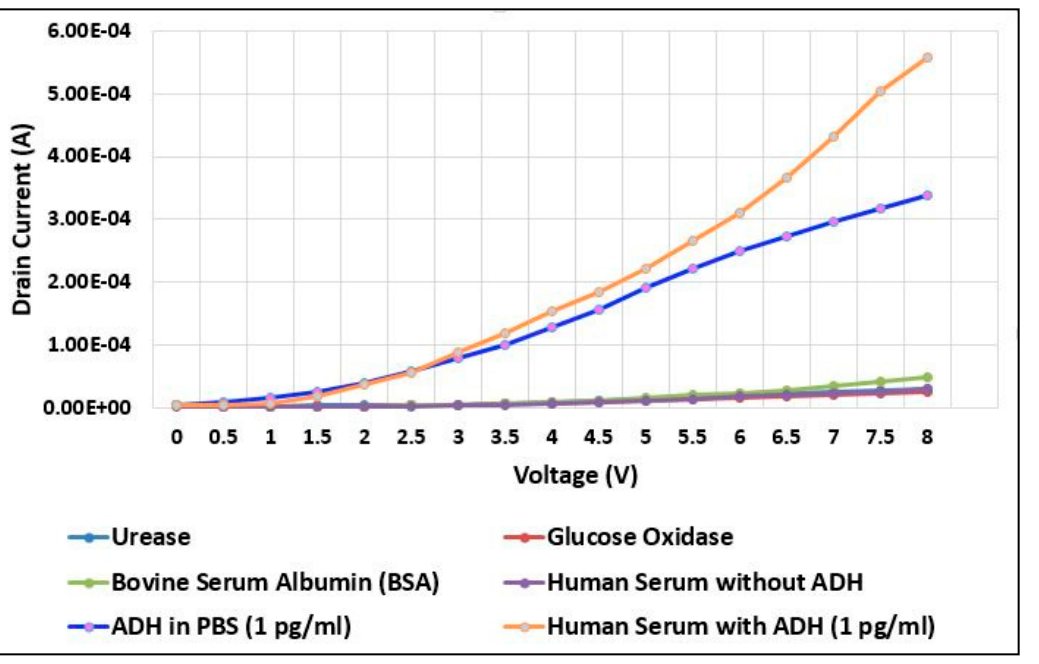
Figure 6. Specificity analysis of ADH biosensor tested with ADH spiked in phosphate-buffered saline (PBS) buffer, ADH spiked in human serum and other biomolecules.